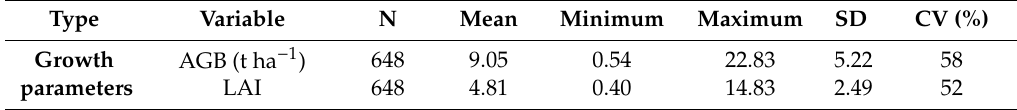
Table 2. Descriptive statistics of growth parameters for experiments in 2017 and